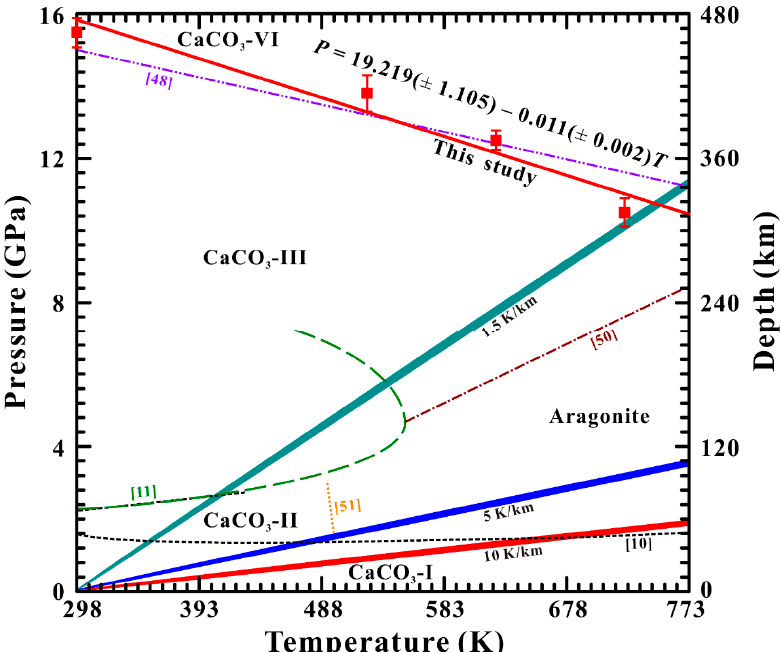
Figure 10. Temperature–pressure phase diagram of calcite according to the current and previous experimental investigations in the conditions of temperatures up to 773 K and pressures up to 16.0 GPa at the depth range of 0–480 km. The red solid squares are based on our present electrical conductivity experimental results. The red solid line is the fitted phase transition boundary between CaCO 3 -III and CaCO 3 -VI phases. The black dashed lines are the phase transition boundaries of CaCO 3 -I to CaCO 3 -II phases and CaCO 3 -II to CaCO 3 -III phases through high-temperature and high-pressure Raman scattering experimental results, coming from Yuan et al. [10]. The olive dashed curve comes from Suito et al. [11], standing for the phase transition boundary from CaCO 3 -III phase to aragonite. The wine dot-dash line is the phase boundary from CaCO 3 -III phase to aragonite by Bayarjargal et al. [50]. The orange dotted line represents the CaCO 3 -II phase to aragonite boundary reported by Hess et al. [51]. The violet dot-dash line is the phase boundary between CaCO 3 -III and CaCO 3 -VI phases from Koch-Müller et al. [48]. The red, blue, and green areas represent the hot, cold, and very cold subducting slabs with the respective geothermal gradient values of 10 K/km, 5 K/km and 1.5